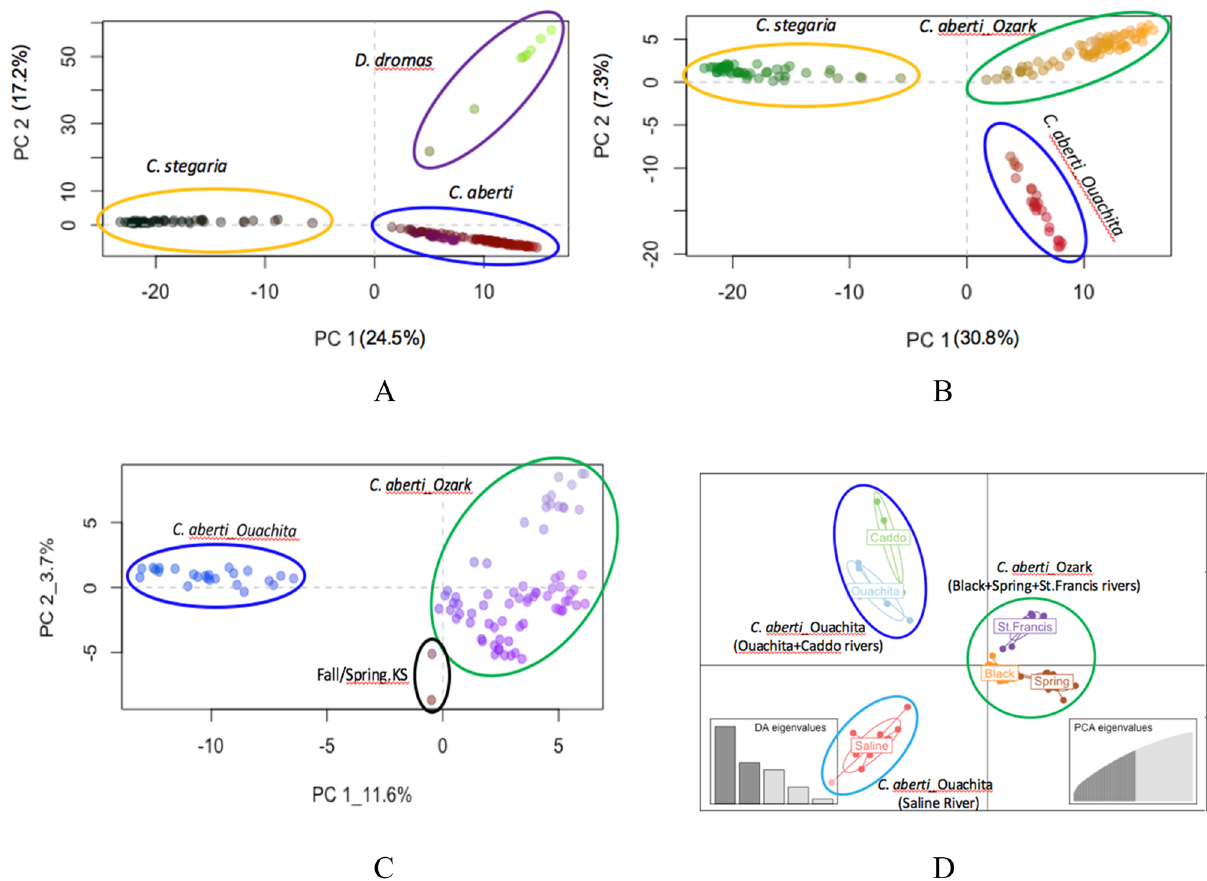
Figure 1. Results of the Principal Component Analyses (PCA) and Discriminant Analysis of Principal Components (DAPC) in R. In this Figure, genetic diversity is represented in two ways: by the distances (further away = more genetically divergent), and by the colors (more divergent colors = more genetically divergent). ( A ) PCA for entire 156 samples representing three freshwater mussel species ( Cyprogenia + Dromus ), ( B ) PCA for 148 samples representing genus Cyprogenia , ( C ) PCA for 97 samples representing Cyprogenia aberti . ( D ) DAPC for 97 samples representing Cyprogenia aberti (Number of PCA axes retained = 50, and number of PCA axes retained =